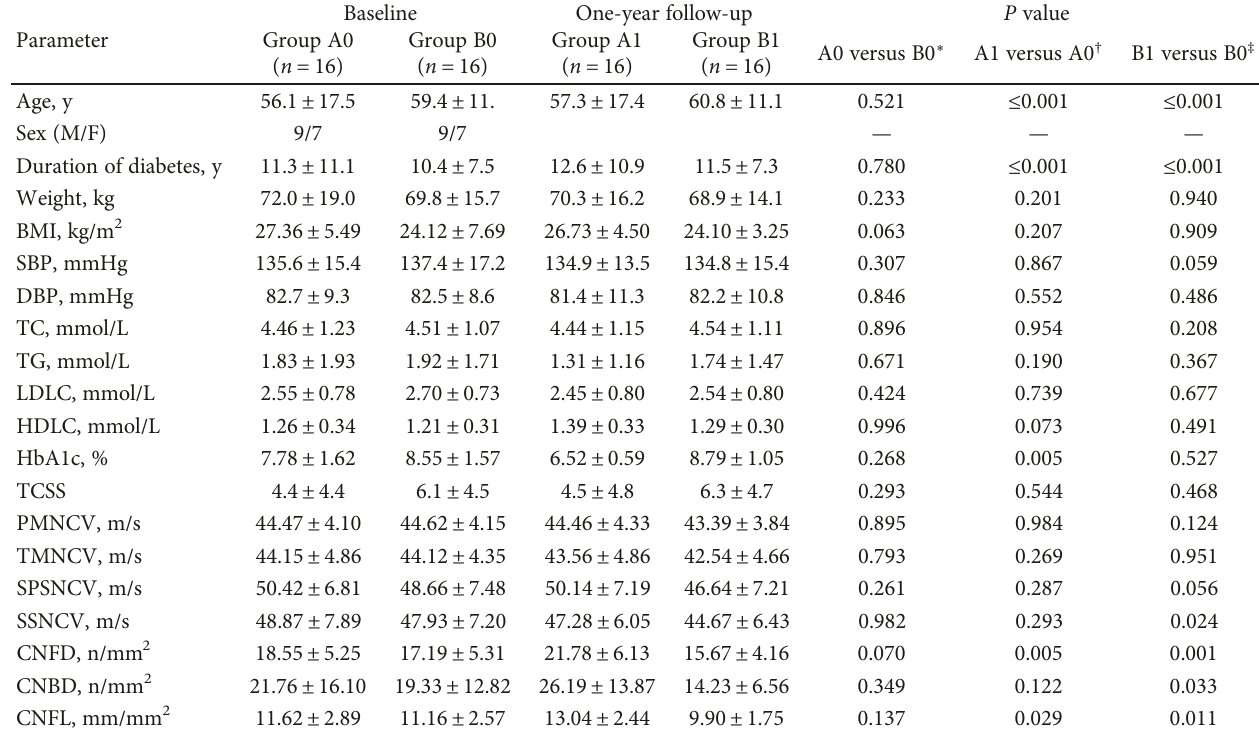
Table 2: Clinical characteristics of patients with type 2 diabetes with improved HbA1c at one-year follow-up (group A) and consistently poor glycemic control at one-year follow-up (group B). Parameter